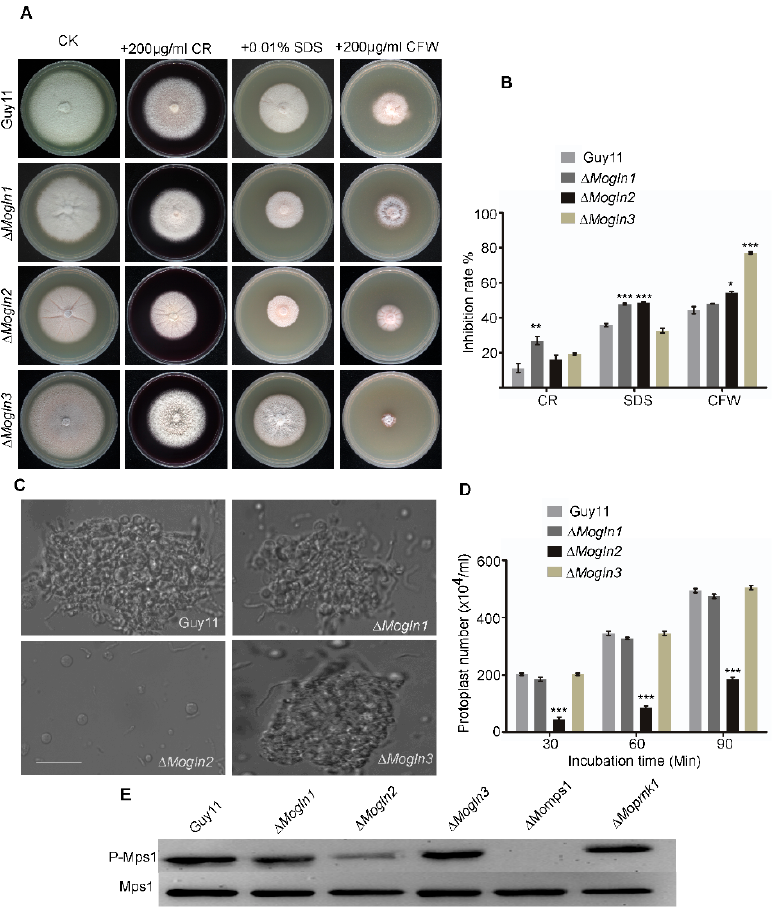
Figure 10. MoGLN2 is essential for maintenance of cell wall integrity in M. oryzae . ( A ) The Guy11 and MoGLN mutants were cultured on CM medium supplemented with (200 μ g/mL CR, 0.01% SDS, and 200 μ g/mL CFW) at 28 °C for 8 days before being photographed. ( B ) Graph showing inhibition rate of WT and mutant strains. Inhibition rate was compared to the growth rate of each untreated control (Inhibition rate = (the diameter of untreated strain − the diameter of treated strain)/(the diameter of untreated strain ×100%)). Three independent repeats were performed, with similar results obtained. ( C ) Light microscopic examination of protoplast release after treatment with cell-wall-degrading enzymes for 30 min, 60 min, and 90 min at 28 °C. Bar= 10 μ m ( D ) Graphical representation of protoplast release assay for the WT and three MoGLN mutants. ( E ) Phosphorylation of MoMps1 in WT and three MoGLN mutants, Δ Mops1, and Δ Mopmk1 . Proteins were prepared from mycelia inoculated in liquid CM, and the phosphorylated MoMps1 was detected by binding of the antiphospho-p44/42 antibody, with the Mpk1 antibody as a control. The phosphorylation level of MoMps1 in the Δ Mogln2 strains indicated the reduced activation of MoMps1 . Statistical results for growth inhibition rate and protoplast results were obtained from at least three independent replicates. Error bars represent standard deviations. Asterisks indicate statistically significant differences (*, p < 0.005 **, p < 0.01, ***, p < 0.001; one-way ANOVA was used to analyze data with Tukey’s multiple-comparison test in GraphPad Prism 8).